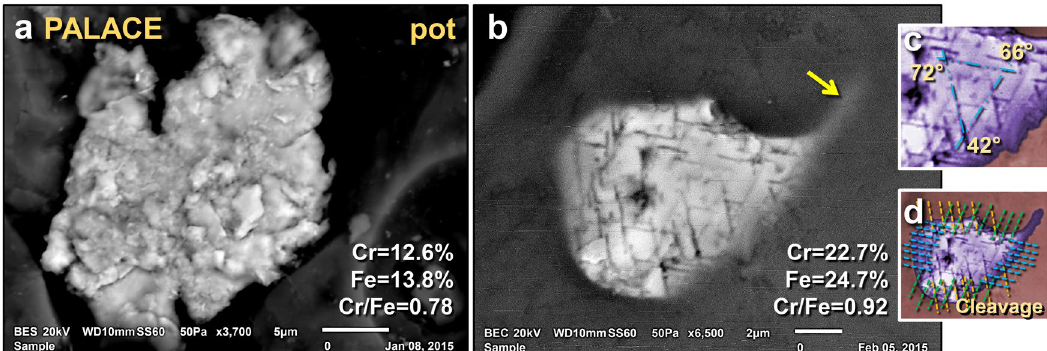
Figure 33. SEM images of melted chromite grains found on a melted potsherd from the palace. ( a ) Shattered, polycrystalline chromite grain that appears to have become agglutinated while molten. ( b ) Melted chromite grain, displaying cleavage (lamellae) suggestive of thermal and/or mechanical shock metamorphism at ~ 12 GPa; ( c ) close-up image showing angles between three sets of crystalline cleavage; ( d ) manually constructed EDS- based phase map showing chromite (purple) embedded in Ca–Al–Si matrix. The lines mark three sets of cleavage extending across the entire grain. A melt tail merging with the matrix is observed to trail off to the upper right of the grain at